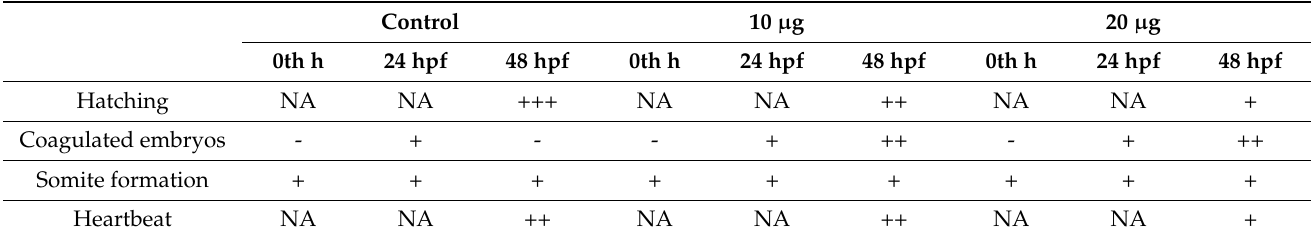
Table 5. Apical observations observed for zebrafish